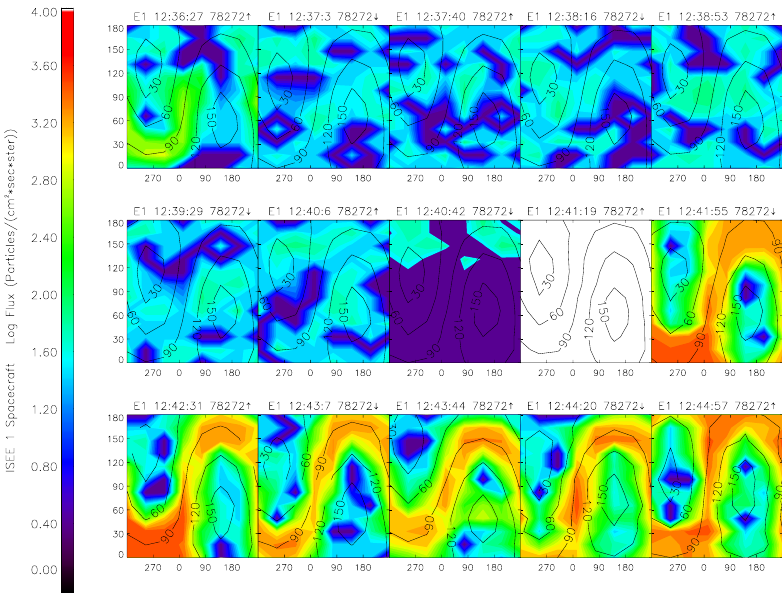
Fig. 5. Electron flux presented similar to Fig. 4, but for the time period 12:36:27–12:44:57 UT. Zone 2 started on the previous figure and ends in the first panel on the top row. Panels 2–8 (12:37:03–12:40:42 UT) show little flux and correspond to the region of increased magnetic field strength between zones 2 and 3, also seen in Fig. 3. The increased flux in the last panel on the second row is the start of zone 3 which continues into Fig. 6.